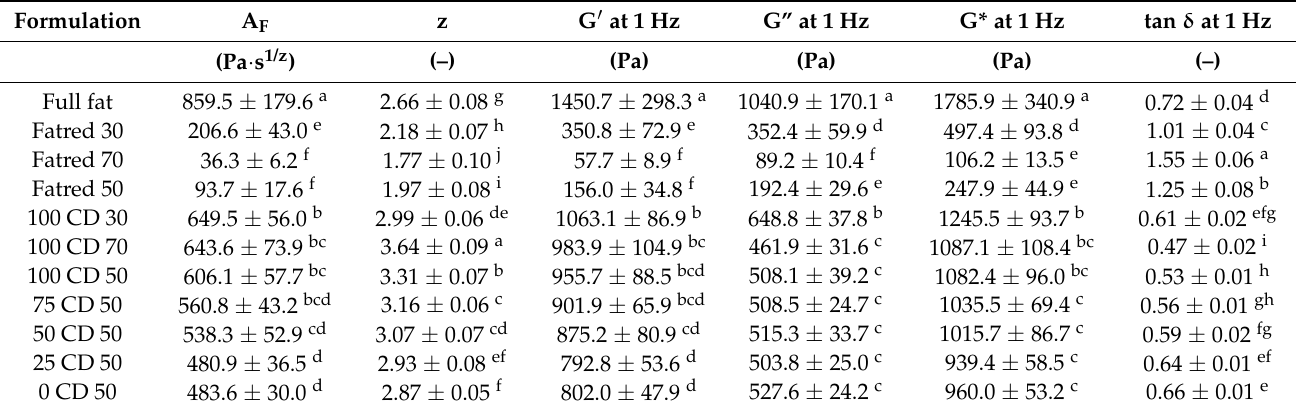
Table 1. Values of gel strength A F and the interaction factor z of Winter’s critical gel theory, as well as the values of storage modulus G (cid:48) , loss modulus G”, complex modulus G*, and loss tangent tan δ at the reference frequency of 1 Hz of the PCS samples.